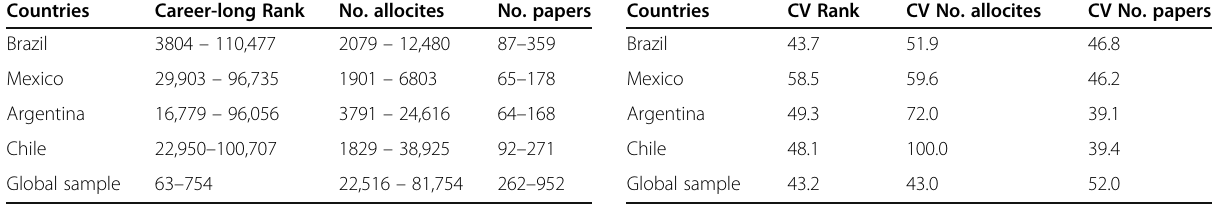
Table 3 Coefficients of variation, CV (%), with regard to position in the Whole trajectory (Career-long) impact ranking, their associated No. allocites, and No. papers in the Scopus database, for the most scientifically productive countries in Latin America (from Table-S6, Career-long ranking, by Ioannidis et al. [3]) Countries CV Rank CV No. allocites CV No.